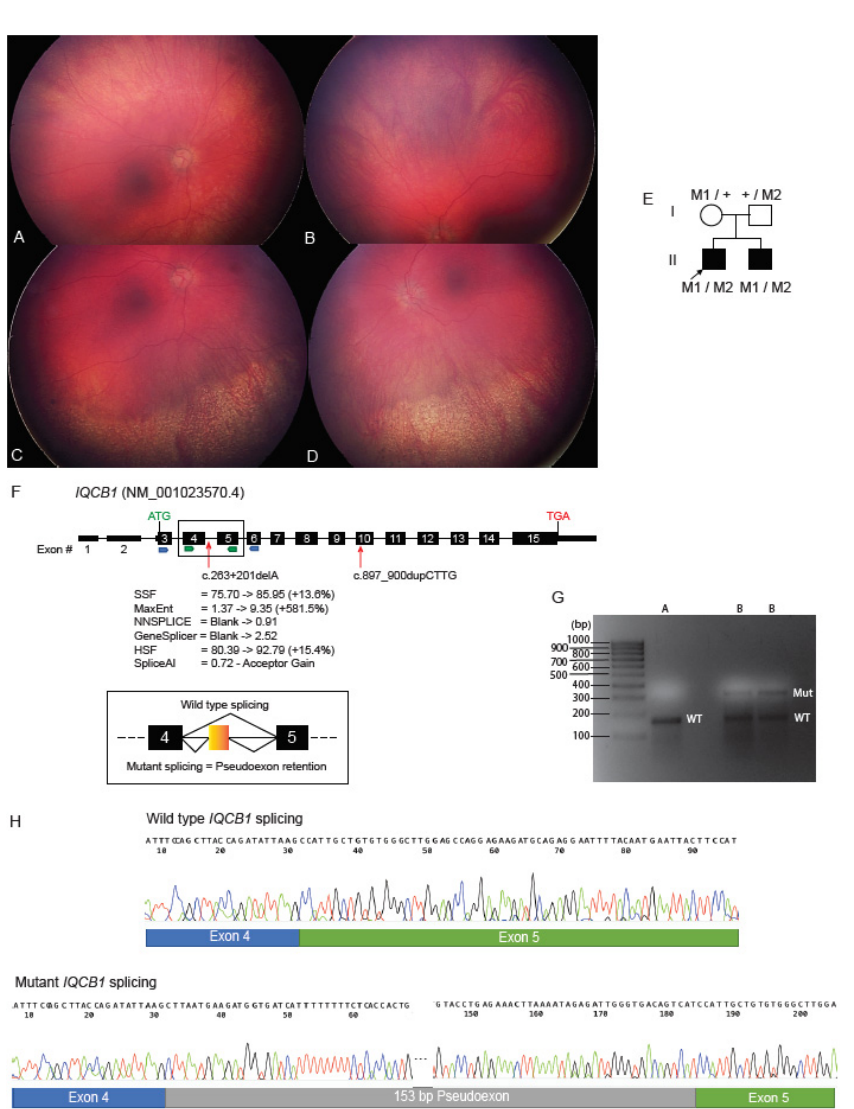
Figure 3. WGS and RNA studies identify a novel deep intronic IQCB1 variant which activates a pseudoexon. ( A ) Right superior fundus, ( B ) Left superior fundus, ( C ) Right inferior fundus, and ( D ) Left inferior fundus shown for proband II.1 with widefield Retcam fundus images (RetCam, Natus, Pleasanton, CA, USA). The main clinical changes are seen in the inferior fundus of each eye ( C , D ). There is retinal atrophy with granular pigmentary changes involving the inferior fundus in each eye. There are also fine speckled pigmentary changes in the superior fundus on clinical exam, which is difficult to appreciate in the Retcam photos. ( E ) Pedigree of Family 3, M1 = IQCB1 :c.897_900CTTGdup, M2 = IQCB1 :c.263 + 201delA, + = wild type; ( F ) Illustration of IQCB1 gene structure, with exon numbering and the location of the variants identified in this study indicated by red arrows. Splicing prediction algorithm data for the novel intronic variant is shown, suggesting the activation of a cryptic acceptor splice site. Coloured arrows underneath indicate primer pair locations in exons 3 to 6 and 4 to 5. Orange box illustrates the location of the pseudoexon introduced between exons 4 and 5; ( G ) Agarose gel image showing the presence of the wild type band [WT, 161bp] in both the control ( A ) and proband ( B ), with the larger sized mutant band [Mut, 314bp] also present in the proband samples; ( H ) Sanger sequencing traces showing the retention of 153bp of intron 4 sequence into the mutant band of IQCB1 RNA. Note: only flanking 5 and 3 (cid:48) ends of the pseudoexon are pictured and not all